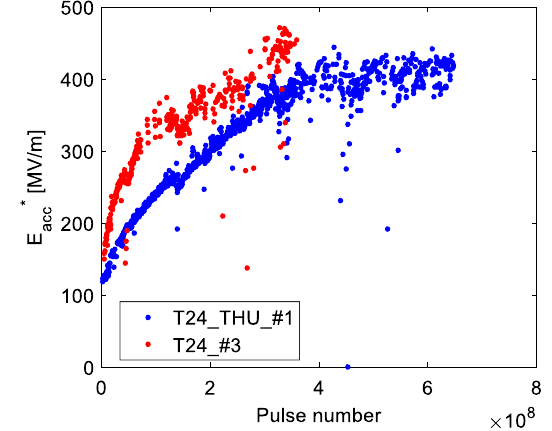
FIG. 15. Comparison of the normalized gradient versus the number of accumulated pulses for T24_THU_#1 and T24_#3.